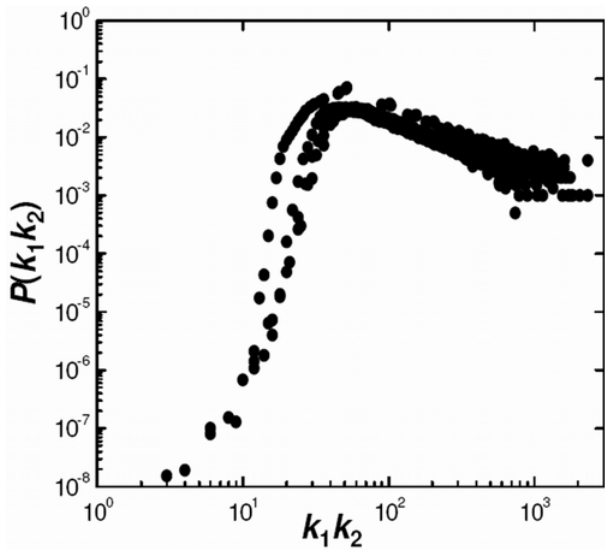
Figure 3. Example of Non-Degree-Weighted Behavior in Networks Generated from a Non-Random Model. The DCDW model was modified to eliminate both random enumeration of nodes and degree-weighted sampling for interacting partners. The degree distribution corresponding to the protein–protein interaction network of Plasmodium falciparum was used as input for the modified model.